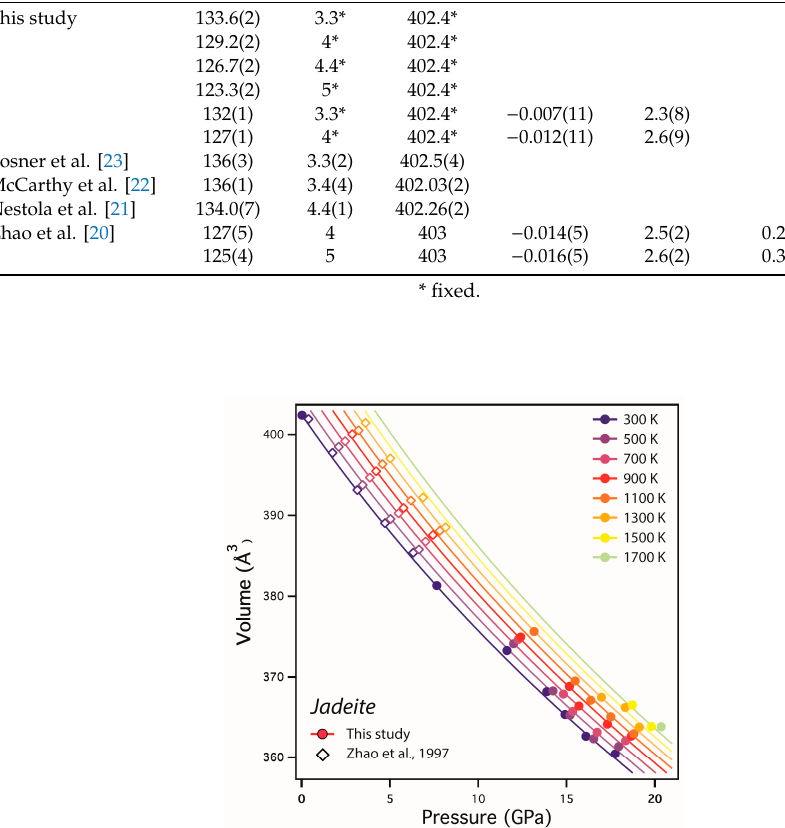
Figure 5. Unit-cell volume of Jadeite as a function of pressure. Data are fit with a Birch–Murnaghan equation (Equation (1)). Table 5. Thermoelastic parameters of jadeite.